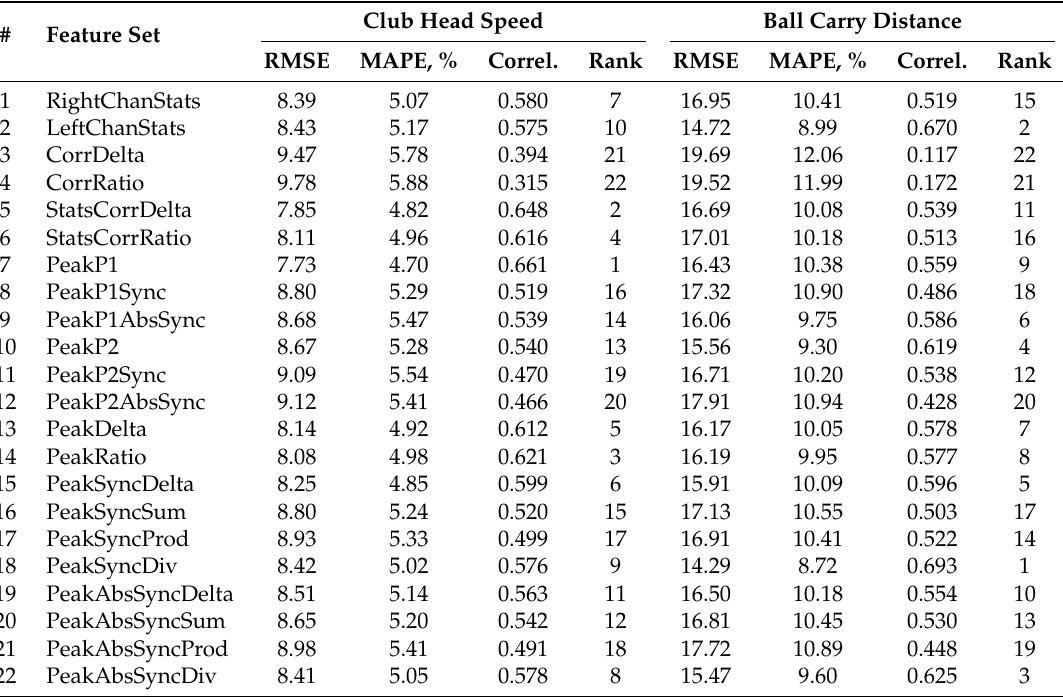
Table 4. RF OOB performance for the regression task.